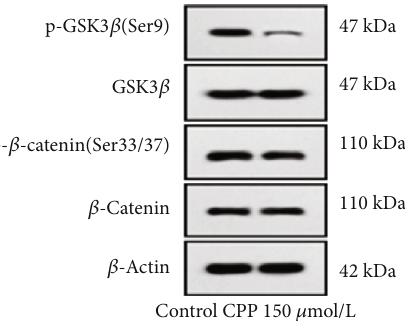
Figure 7: CPP inhibits GSK3 β / β -catenin signaling pathway activation. Compared with the control group, ∗ indicates p < 0 : 05 . This experiment was repeated three times